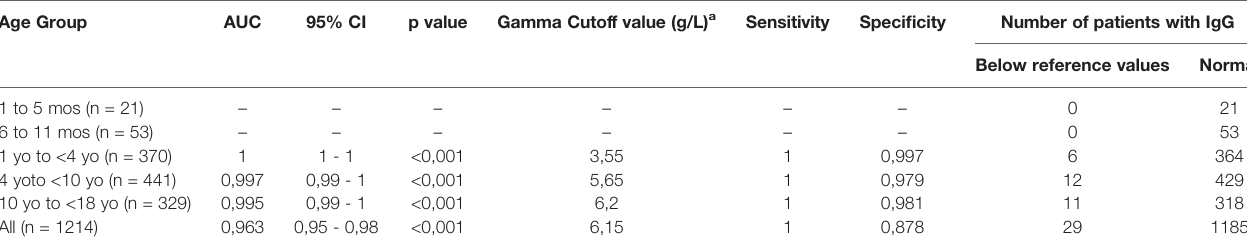
TABLE 4 | Gamma fraction values as a function of IgG